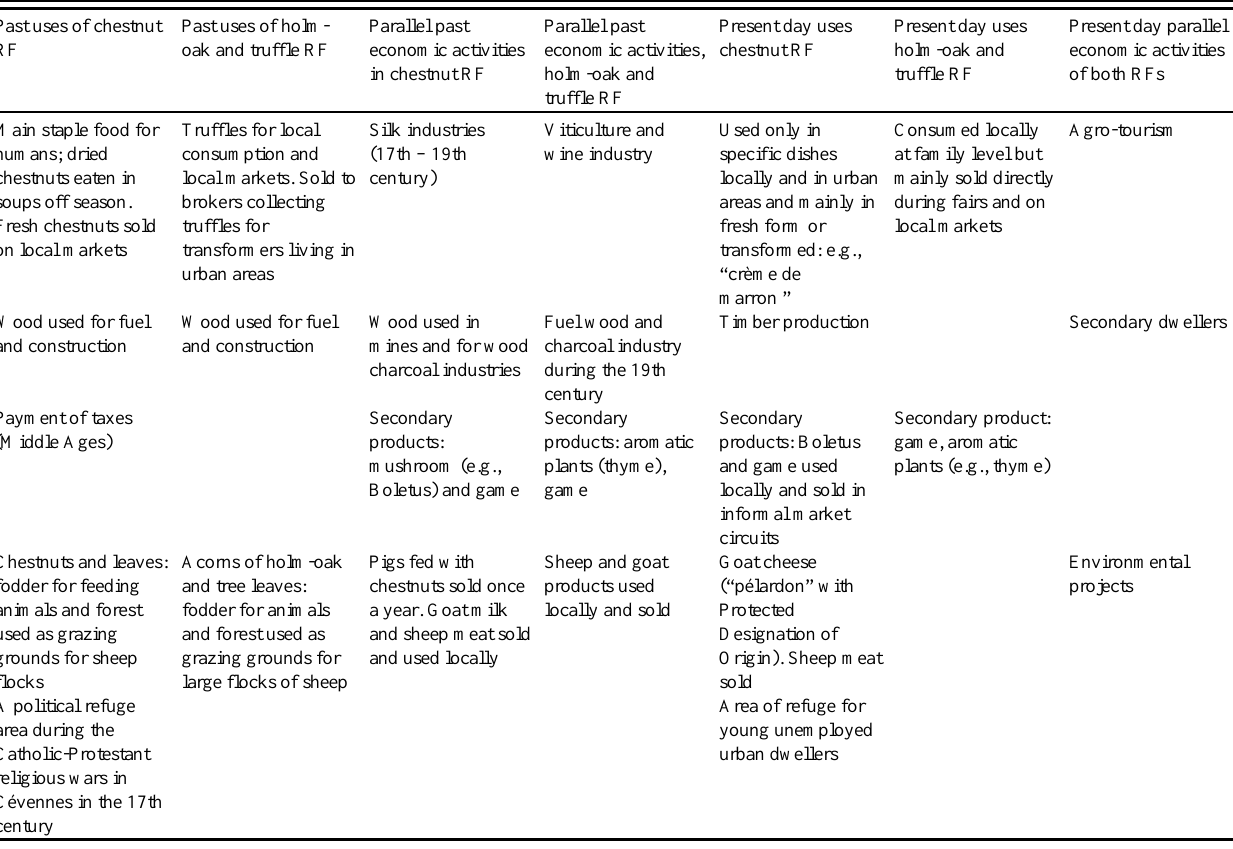
Table 1 . Past and present chestnut ( Castanea sativa Mill.) and holm-oak ( Quercus ilex L.) rural forests (RFs) use. (Sources: primary data and bibliographic sources Chatin 1892, Pelen 1987, Dalonis 1996, and Travier